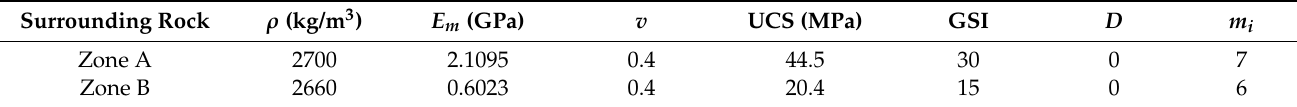
Table 2. Parameters of surrounding